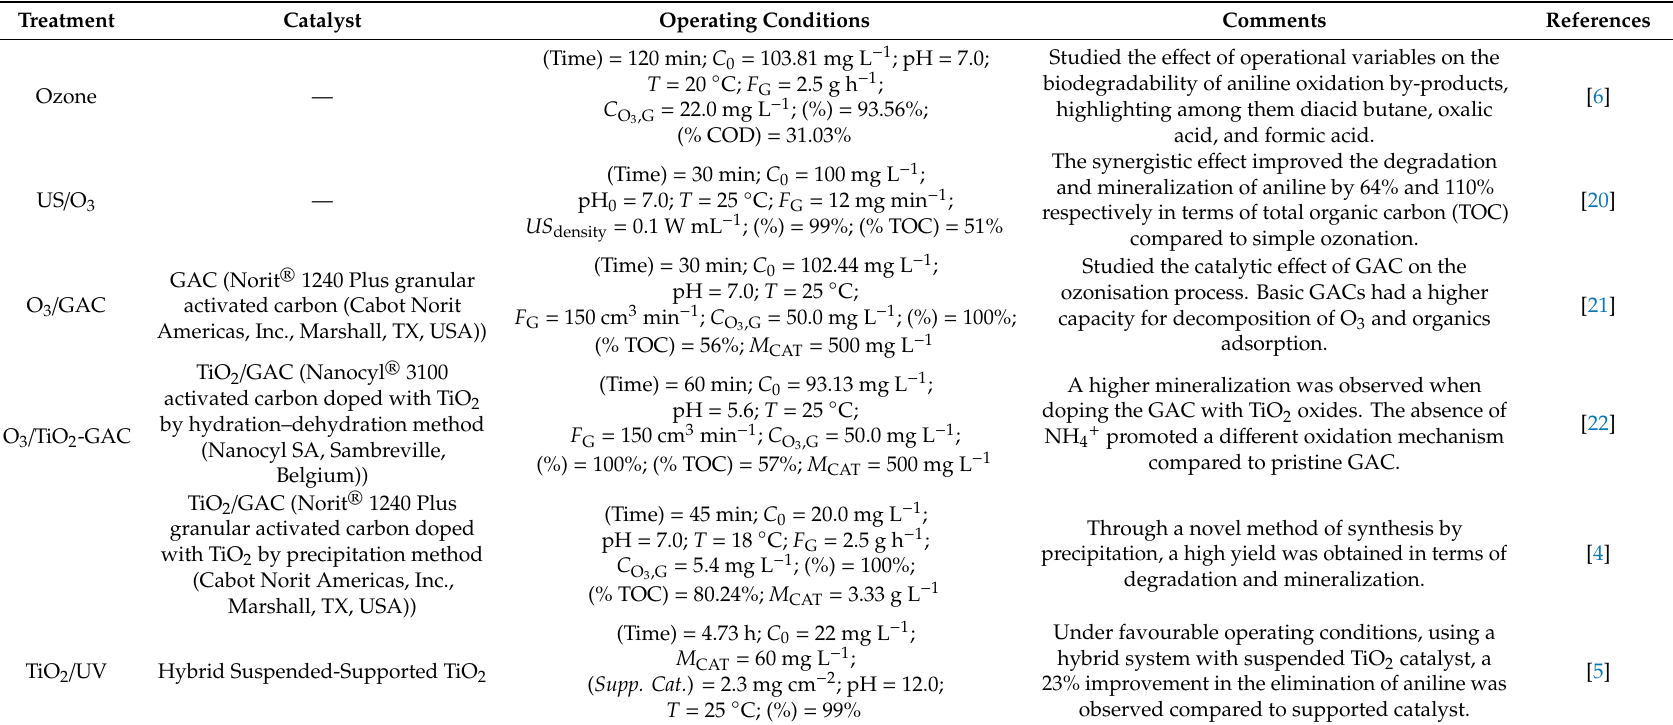
Table 1. Previous studies regarding the treatment of industrial wastewater containing